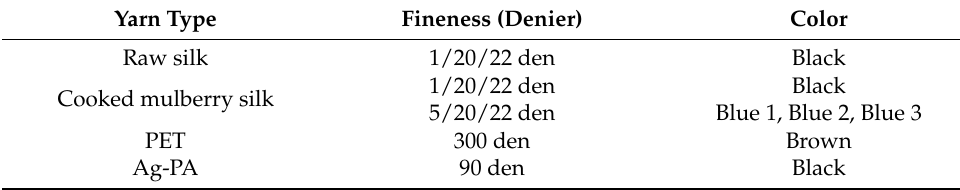
Table 1. Details of the used yarns.